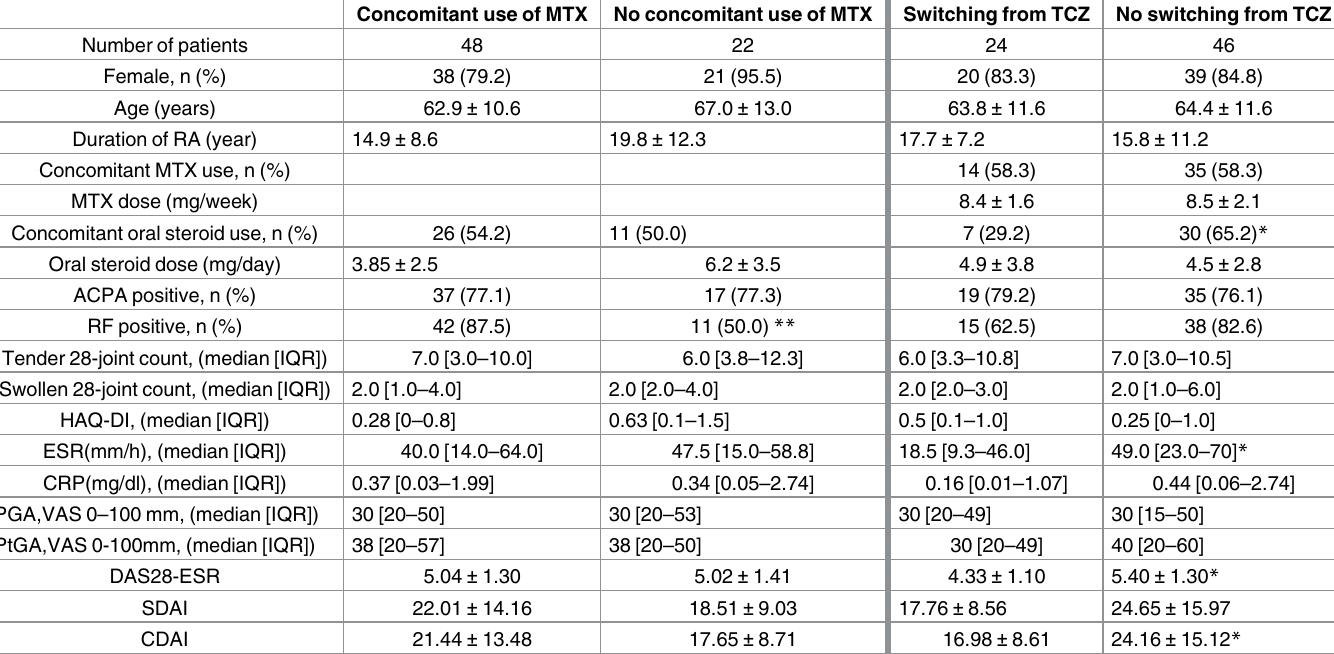
Table 3. Comparison of baseline characteristics in patients with different